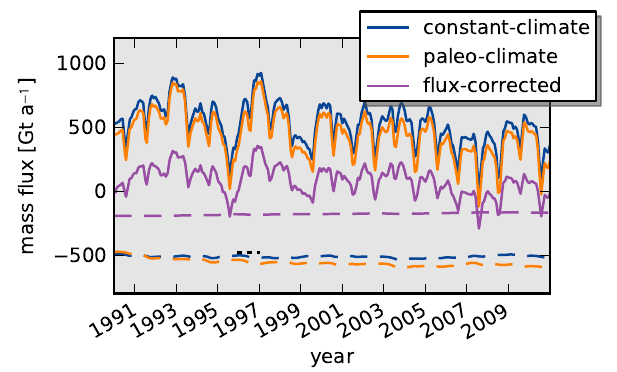
Fig. 5. Simulated mass fluxes from 1990 to 2010. Climatic mass balance (solid line) and ice discharge (dashed line). For comparison the ice discharge estimate for 1996 (van den Broeke et al., 2009) is shown (black dotted line). Time series are smoothed with a 13- month running-average